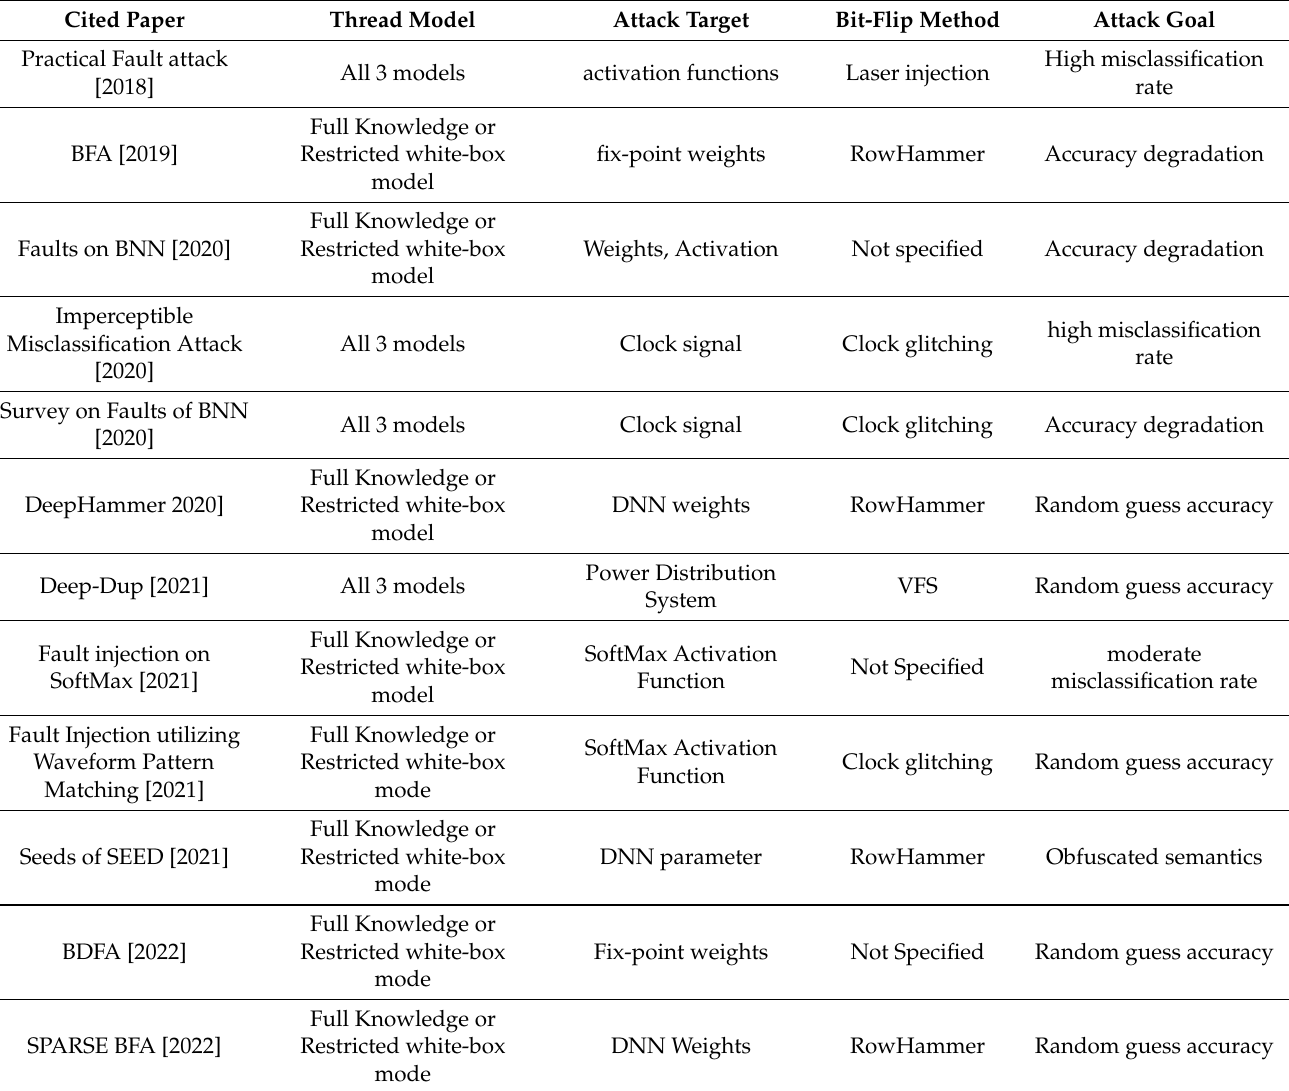
Table 2. The detailed attack aspects for untargeted bit-flip